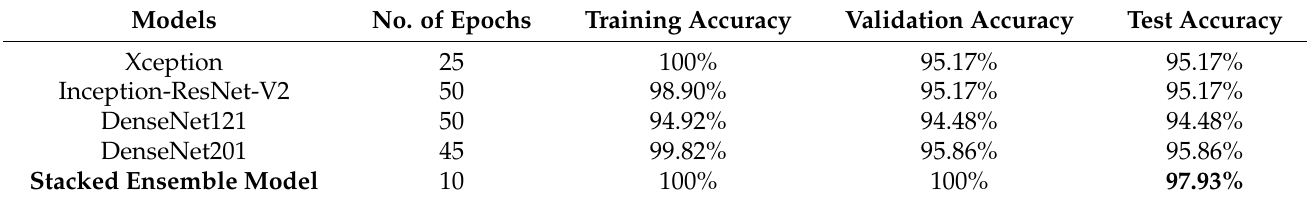
Table 6. Performance comparison of each pre-trained model and stacked ensemble model.